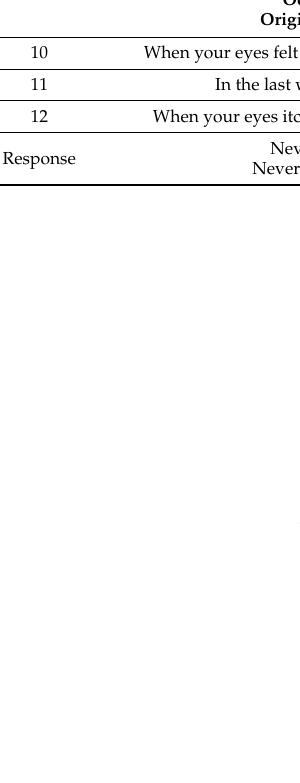
Table 2. Rasch Fit Statistics and Item Measure for OCI VE